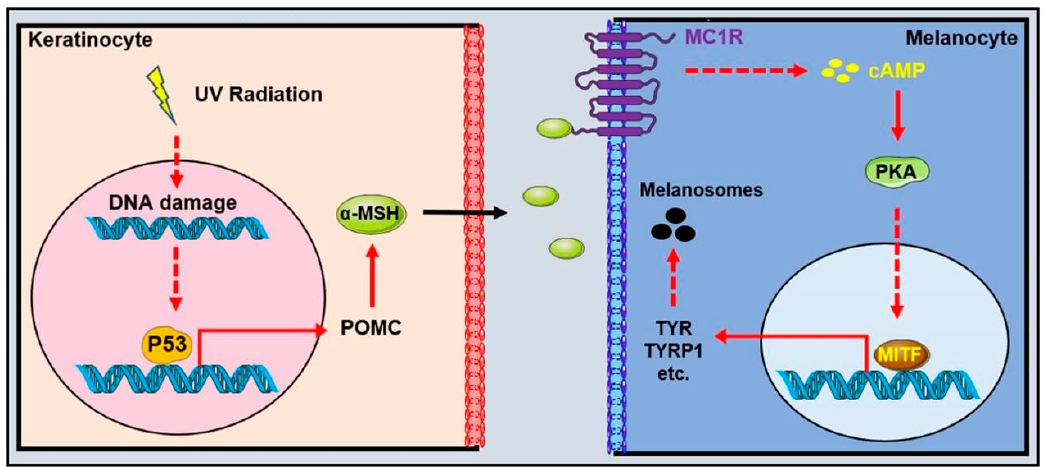
Figure 1. Schematic diagram of melanin production induced by ultraviolet radiation. UVR-induced P53 upregulation activates the transcription of opioid cortisol (POMC) in keratinocytes. POMC pro- tein is then cleaved to form α -melanocyte stimulating hormone ( α -MSH). α -MSH binds to its recep- tor, the melanocortin 1 receptor (MC1R), on cell membrane of melanocytes to induce the production of a circular AMP that activates the microphthalmic-associated transcription factor (MITF)-induced melanin enzymes’ transcription, including TYR, DCT and so on.